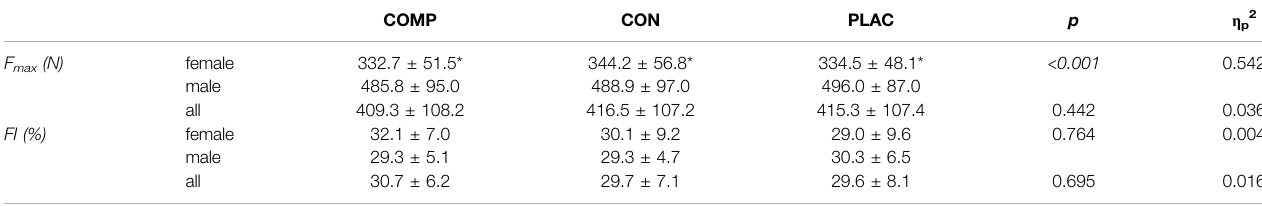
TABLE 2 | Performance outputs for intermittent hand grip strength and endurance measurements of female ( n = 12), male ( n = 12), and all ( n = 24)